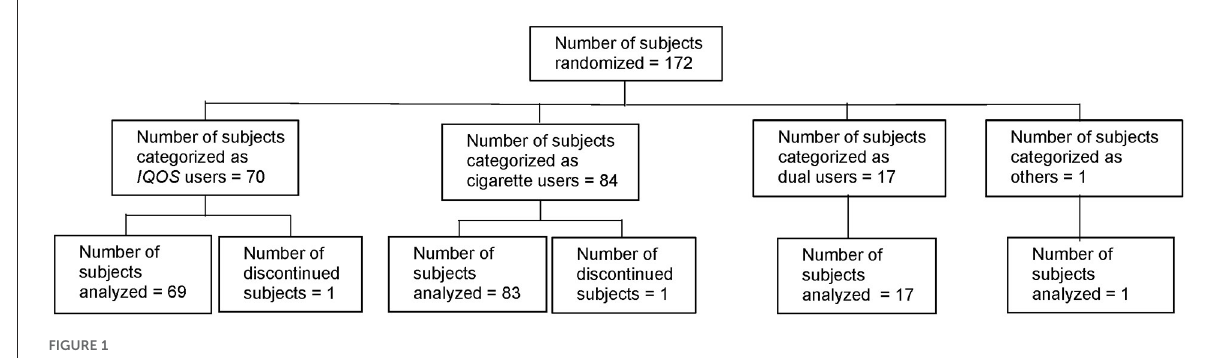
FIGURE1 Participant